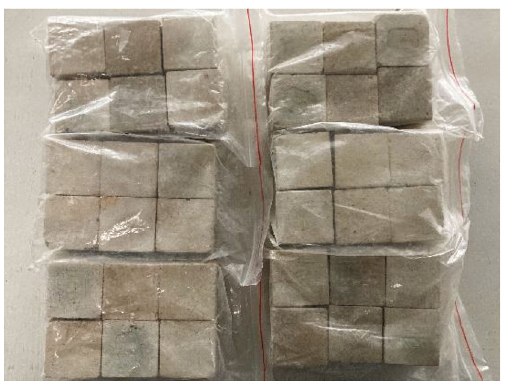
Figure 1: Mud sample.